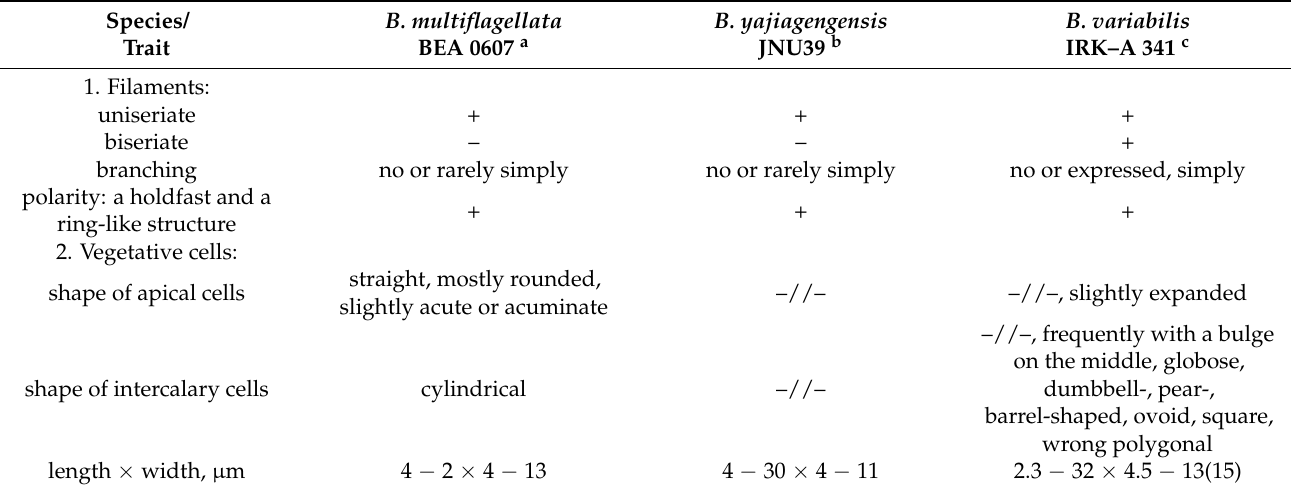
Table 1. Comparison of morphological traits of the Barranca